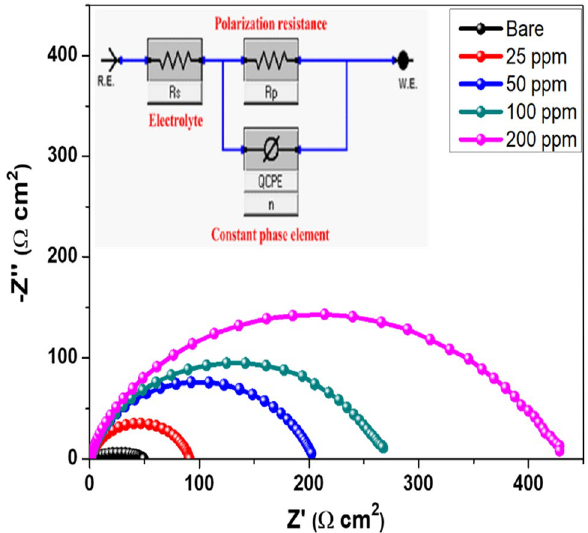
Figure 10. Nyquist plots of the bare and different coated mild steel samples in 3.5 wt.% NaCl solution at 25 °C (Inset: Equivalent circuit used to fit the experimental EIS data).